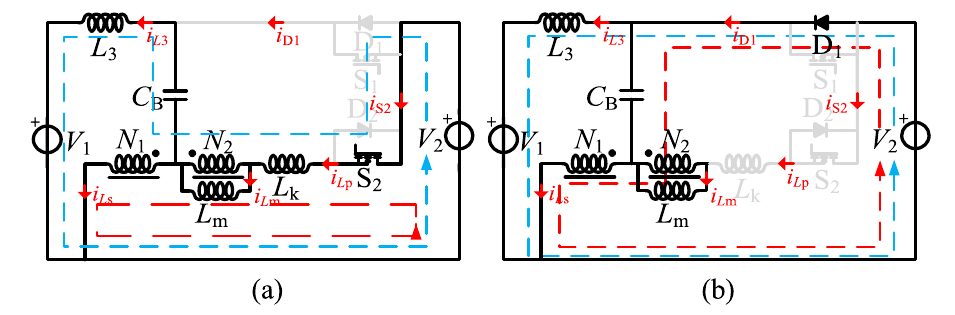
Figure 9. The equivalent circuit of the operation modes in the step-up mode, ( a ) S 2 on, ( b ) S 2